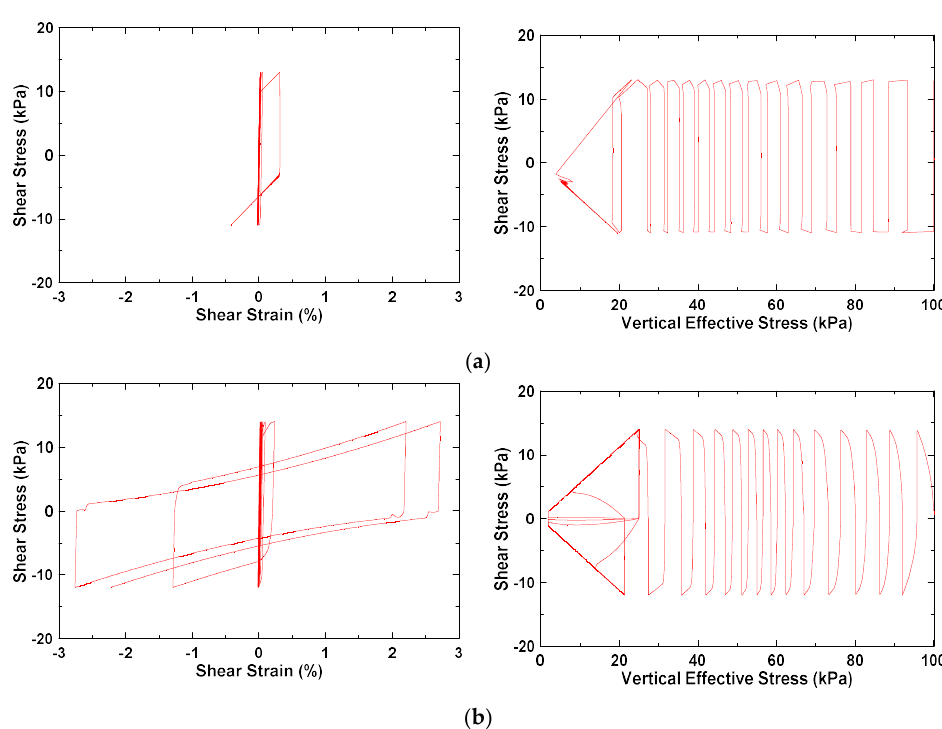
Figure 3. Undrained cyclic DSS loading response for (N 1 ) 60cs = 10 of the JRA96 procedure with vertical effective consolidation stress σ vc ′ = 101 kPa and initial static shear stress = 0. ( a ) Finn model; ( b ) UBCSAND model. Appl. Sci. 2021 , 11 , x FOR PEER REVIEW